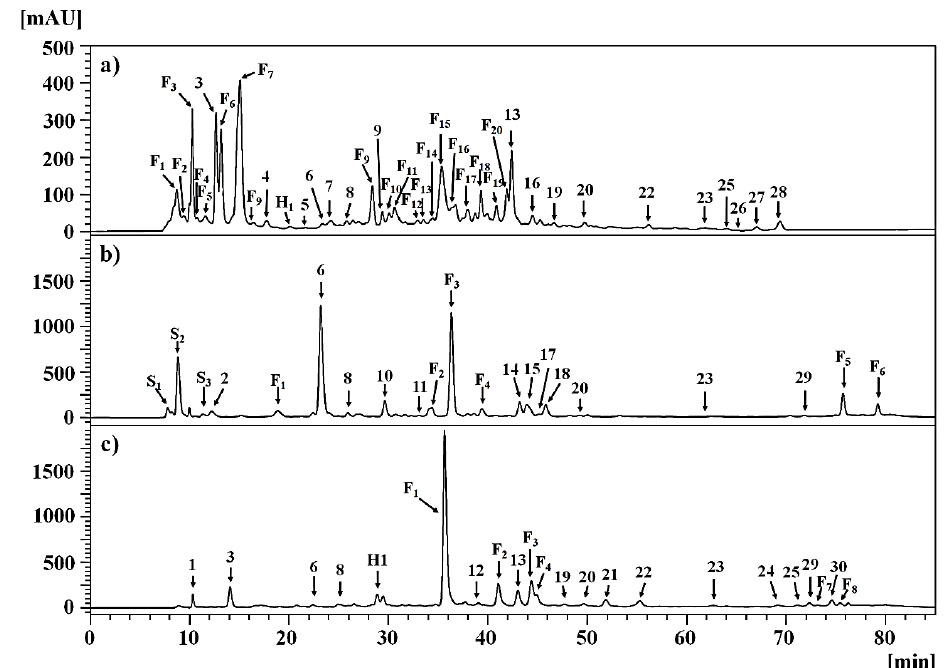
Figure 1. HPLC-DAD chromatogram of the PEEs measured at 280 nm from the aerial parts of ( a ) Clinopodium gilliesii , ( b ) Mutisia acuminata , and ( c ) Tagetes multiflora . F: flavonoid-type, S: simple phenolic; H: hydroxycinnamic acid-type. The number refers to compounds identified by matching with commercial standards.